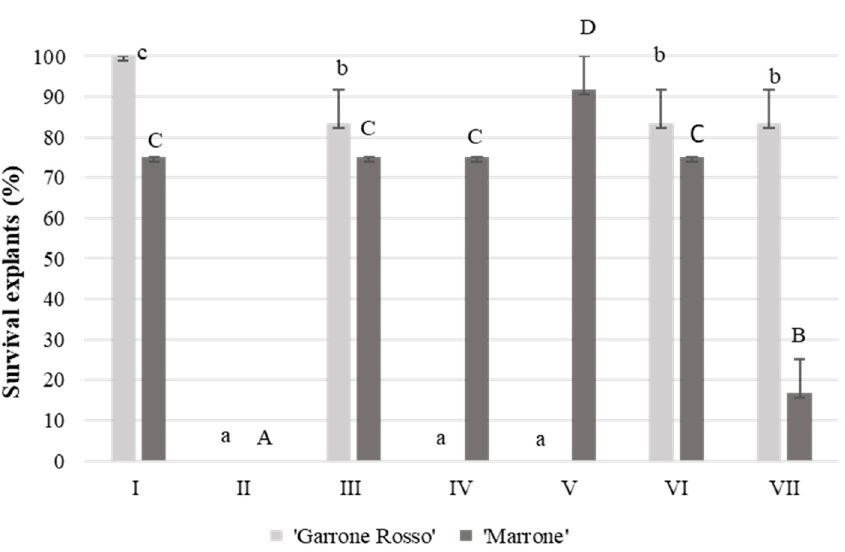
Figure 1. Effect of different sterilization treatments on in vitro establishment of two European chestnut cultivars ‘Marrone di Castel del Rio’ and ‘Garrone Rosso’. Treatments tested: (I) 30 sec in 70% ethanol + 10 min in 33% v / v bleach + 0.2% PPM TM , (II) 2% PPM TM , (III) 30 sec in 70% ethanol + 10 min in 33% v / v bleach, (IV) 30 sec in 70% ethanol + 20 min in 33% v / v bleach + 0.2% PPM TM , (V) 25 min in 33% v / v bleach, (VI) 10 min in 33% v / v bleach, (VII) 30 sec in 70% ethanol + 5 min in 33% v / v bleach. Data shows the percentage of green/survival explants. In the case of treatments II, IV and V, the ‘Garrone Rosso’ cultivar showed 0% explant survival, with the same for the ‘Marrone di Castel del Rio’ cultivar in treatment II. Data are the means of three biological replicates (15 nodal explants each) ± SE. For each cultivar, means with the same letter do not significantly differ at p ≤ 0.05 (Tukey’s HSD test). Lowercase letters and capital letters were used for ‘Garrone Rosso’ and ‘Marrone di Castel del Rio’ respectively.